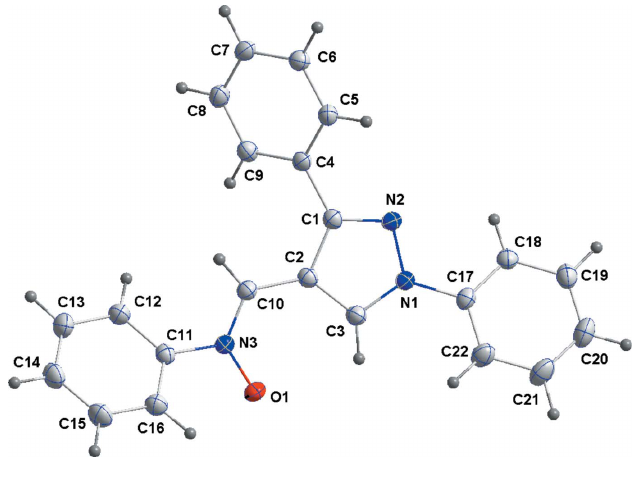
Figure 1 The title molecule, shown with 50% probability displacement